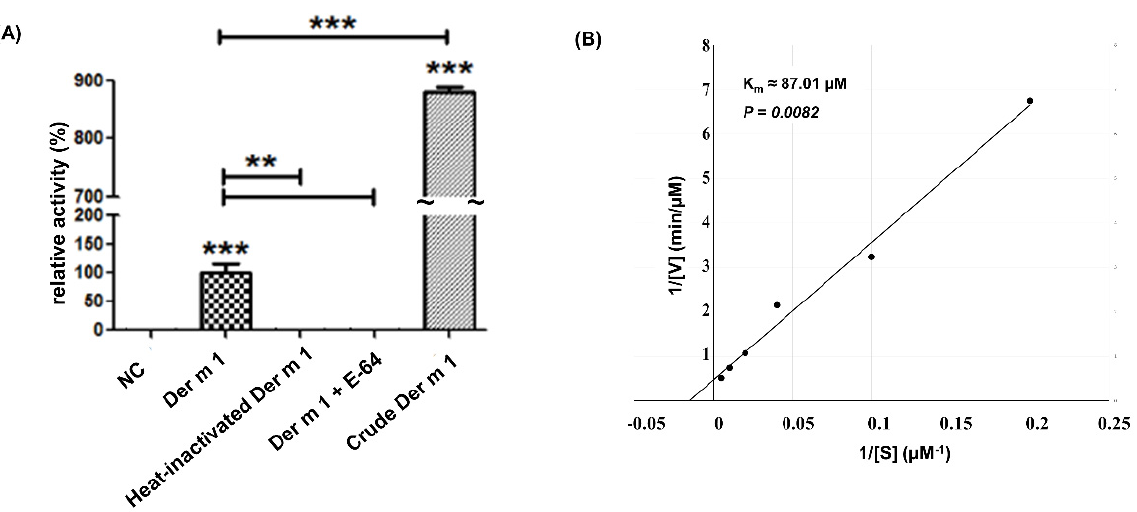
Figure 3. The protease activity assay of the truncated recombinant Der m 1 . The activity assay used different concentrations of Boc-QAR-MCA as substrate and a final 2 μ M recombinant Der m 1 at 37 °C for 30 min in 96-well plates, determined by ELISA reader. The excitation and emission values are 360 nm and 460 nm, respectively. ( A ) The cysteine protease inhibitor, E-64, indeed decreased the activity of Der m 1 , as the heat-inactivated Der m 1 did. ( B ) The Lineweaver–Burk plot showed the Km of recombinant Der m 1 was 87.01 μ M. ** p < 0.01, *** p < 0.001 compared with NC or Der m 1 as indicated.